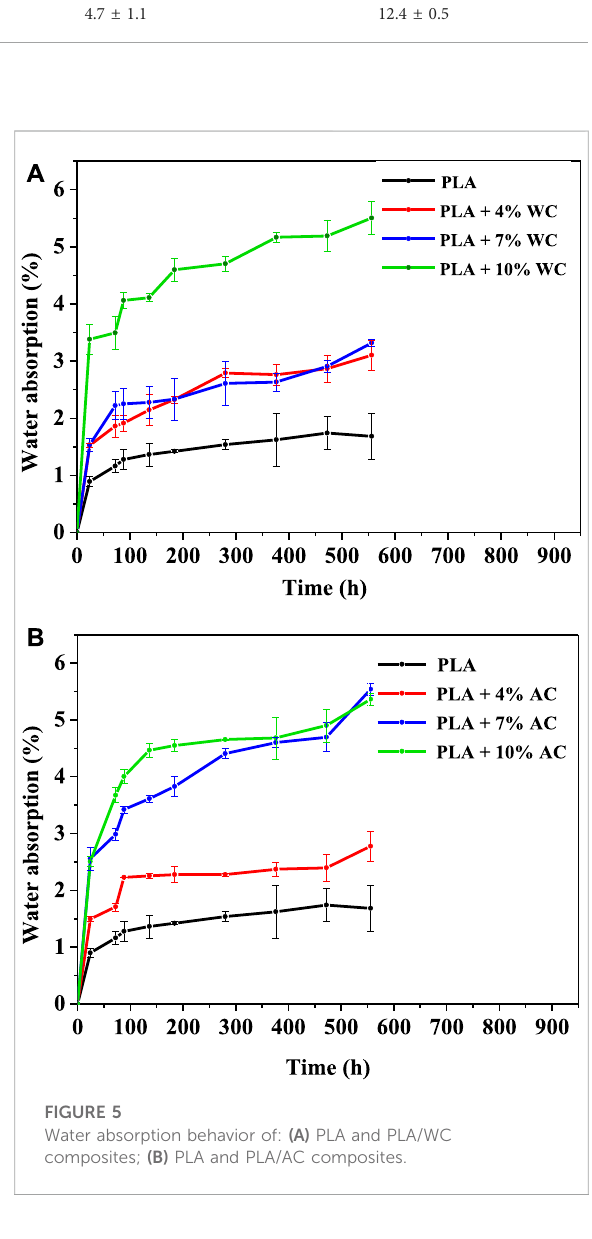
FIGURE 5 Water absorption behavior of: (A) PLA and PLA/WC composites; (B) PLA and PLA/AC